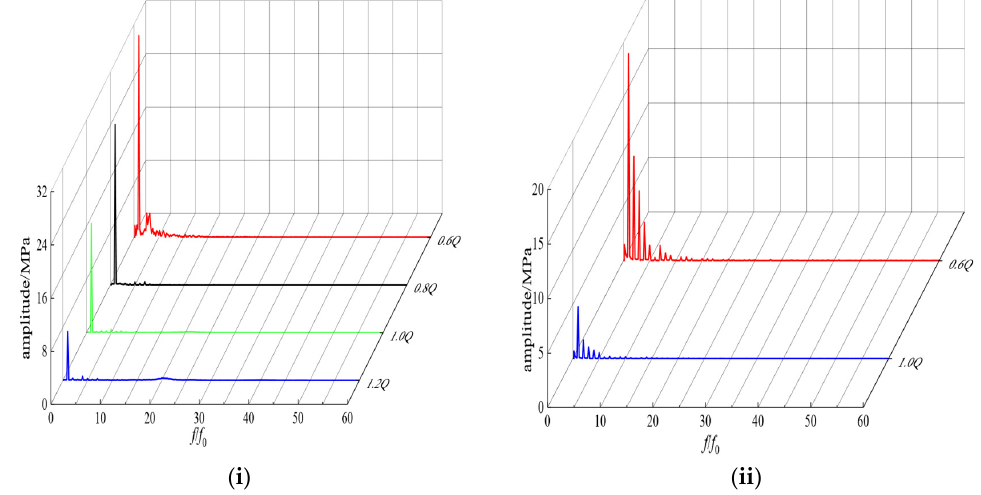
Figure 10. Frequency domain distribution of dynamic stress. ( i ) Pump working conditions, ( ii ) turbine working conditions.